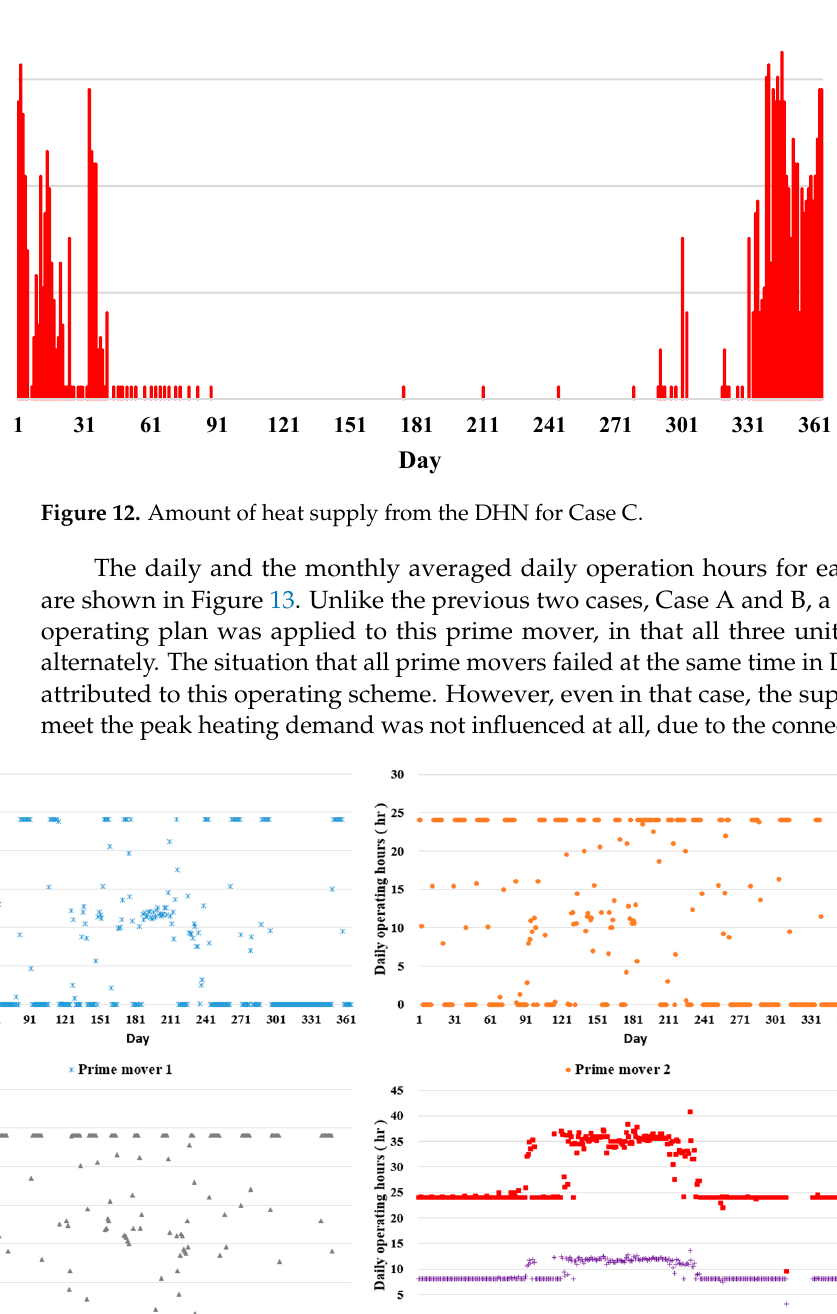
10 of 24 Figure 11. Annual daily fuel consumption profile for CHP for Case C. The amount of heat supply from the DHN is shown in Figure 12. An abrupt increase